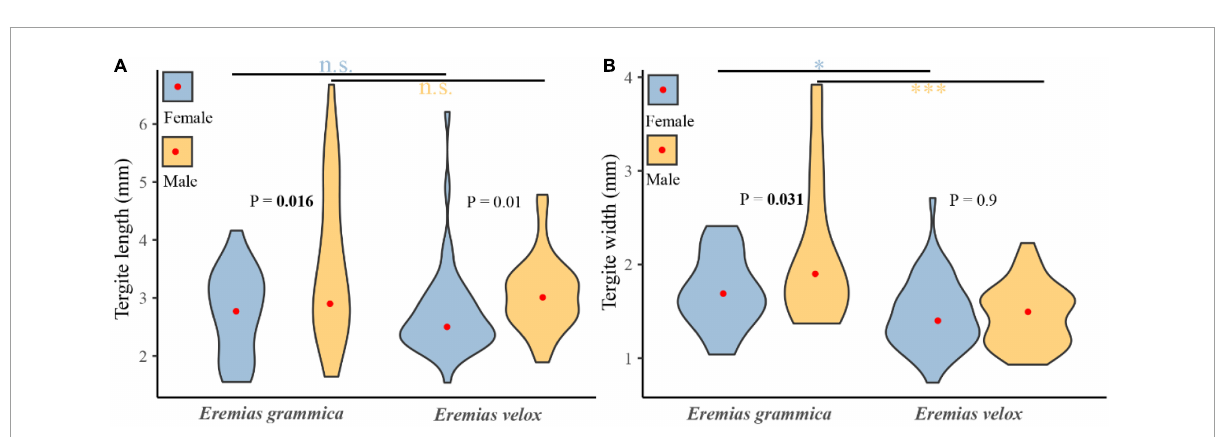
FIGURE5 Differences of tergite length (A) and width (B) between males and females for Eremias grammica and E. velox . The red points are the mean values of size for each group. P– values represent the differences in prey sizes between males and females, and the line represents the differences in sizes between two species of the same sex. ∗ P < 0.05, ∗∗∗ P <